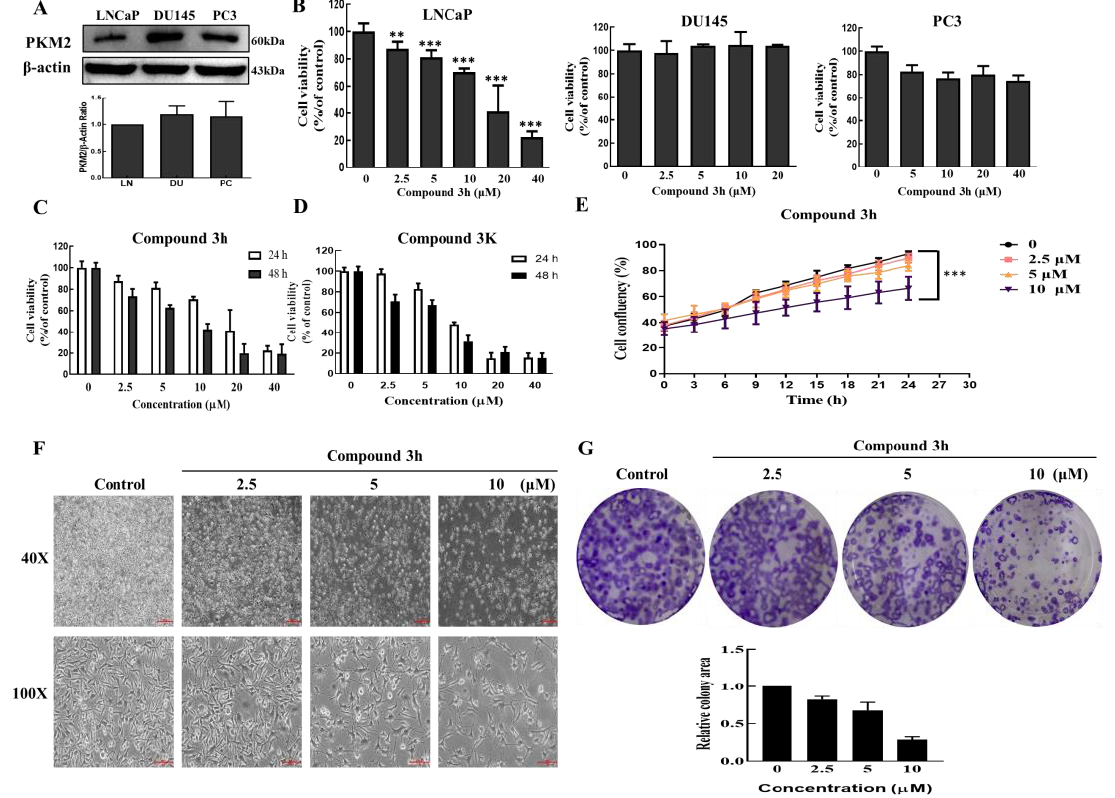
Figure 3. Cytotoxicity of compounds 3h and 3K on three different prostate cancer cell lines. ( A ) The expression of PKM2 LNCaP, DU145, and PC3. ( B ) Cell viability of compound 3h . Compound 3h was treated in LNCaP, DU145, or PC3 cells for 24 h. ( C ) Anticancer effect of compound 3h on LNCaP cells. Cell viability of LNCaP decreased with the increase in compound 3h concentration (0, 2.5, 5, 10, 20, and 40 μM) for 24 and 48 h treatment. Cell viability was assessed using WST assay kit. ( D ) Cytotoxicity effect of compound 3K on LNCaP cells for 24 h and 48 h. ( E ) Compound 3h suppressed the proliferation of LNCaP cells. ( F ) Compound 3h treatment for 48 h caused morphological changes in LNCaP cells. Scale bar, 200 μm (40×), 100 μm (100×). ( G ) Compound 3h treatment inhibited colony formation in LNCaP and the quantitative analysis. The values represent the mean ± SD. ** p < 0.01 and *** p < 0.001. The uncropped blots are shown Supplementary Material.